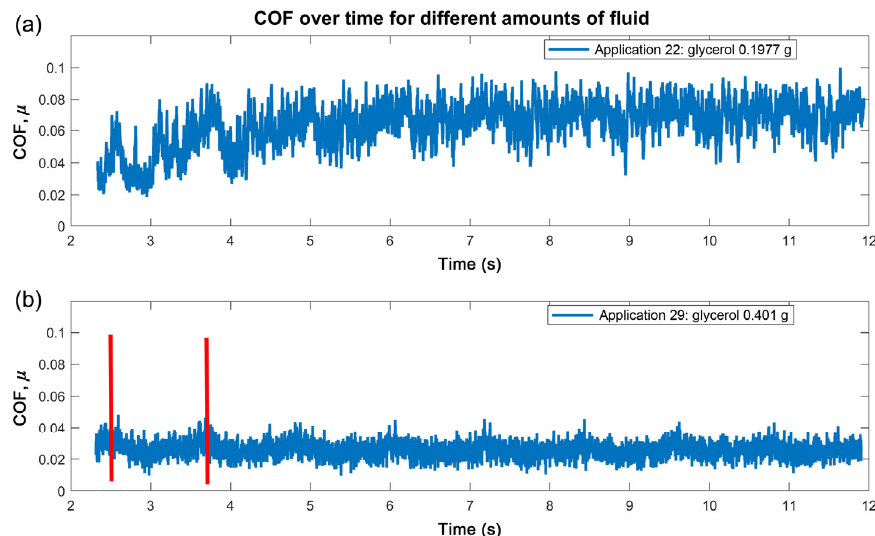
Fig. 9 COF vs. time for two different fluid